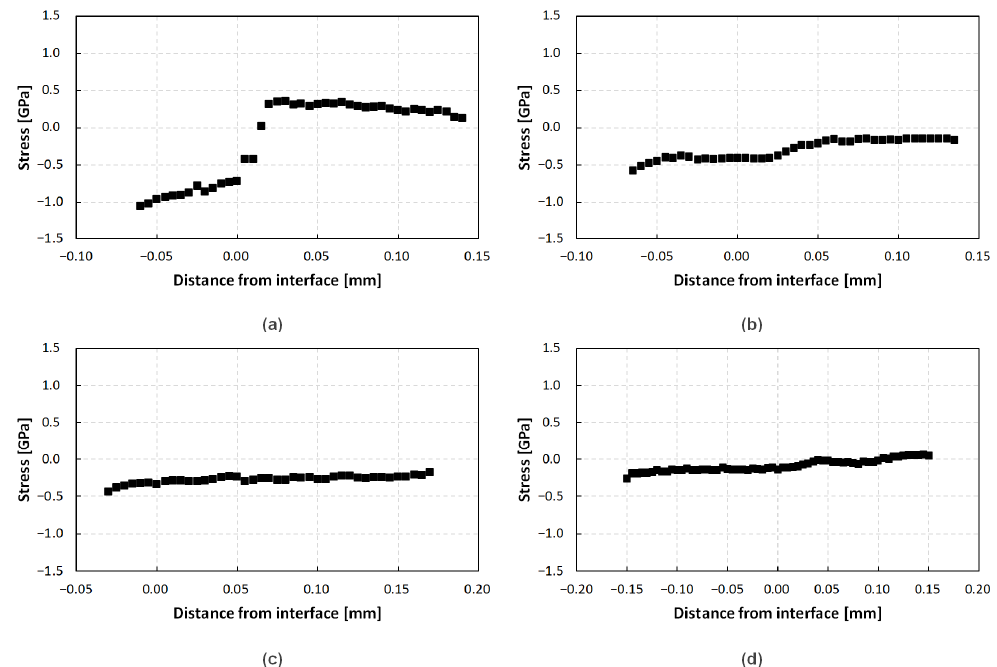
Figure 6. Measured stress across the seed–crystal interface of ( a ) crystal A, ( b ) crystal B, ( c ) crystal C, and ( d ) crystal D, evaluated from Raman measurements of the FTO peak position. The position of the line scan is depicted in Figure 1b,c. A positive distance from interface marks the area of grown crystal, while a negative distance indicates an area of the seed of the crystal.